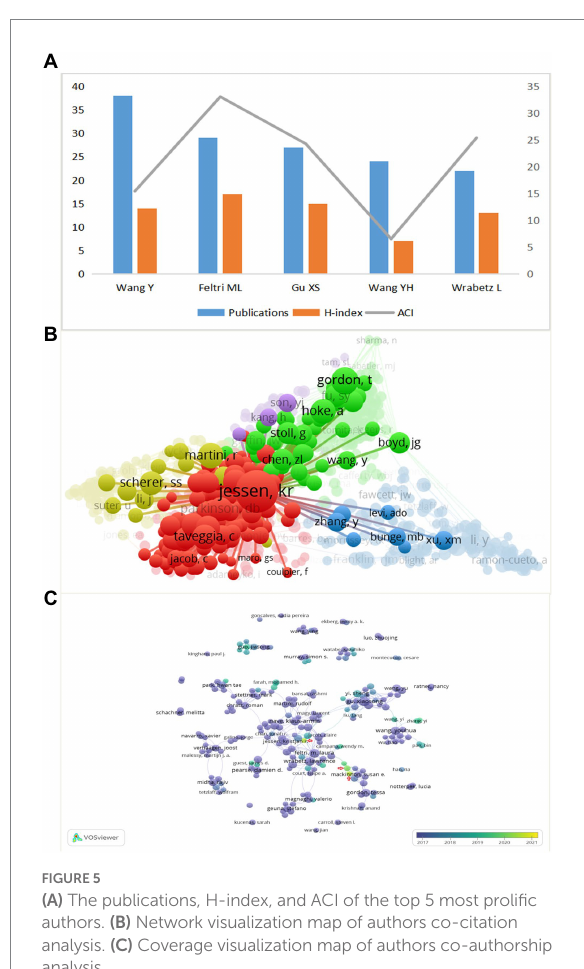
FIGURE 5 (A) The publications, H-index, and ACI of the top 5 most prolific authors. (B) Network visualization map of authors co-citation analysis. (C) Coverage visualization map of authors co-authorship